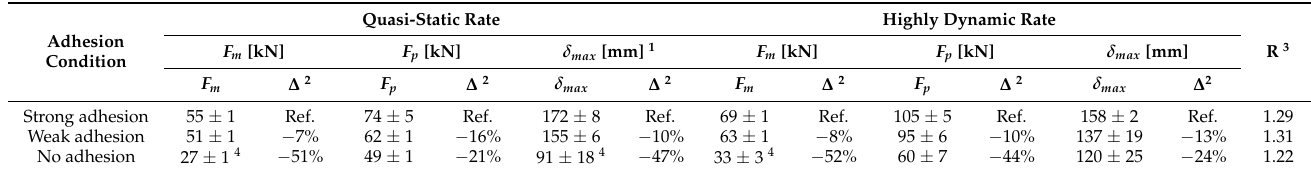
Table 3. Summary of the axial crushing test